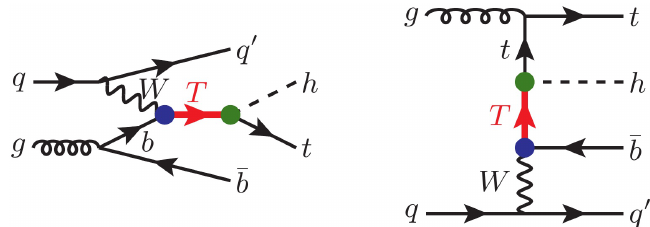
Figure 1 . Representative Feynman diagrams for the pp → ht + X process in the four-flavour- number scheme. We illustrate both resonant s -channel (left) and non-resonant t -channel (right) exchange topologies, when induced by a heavy vector-like quark T